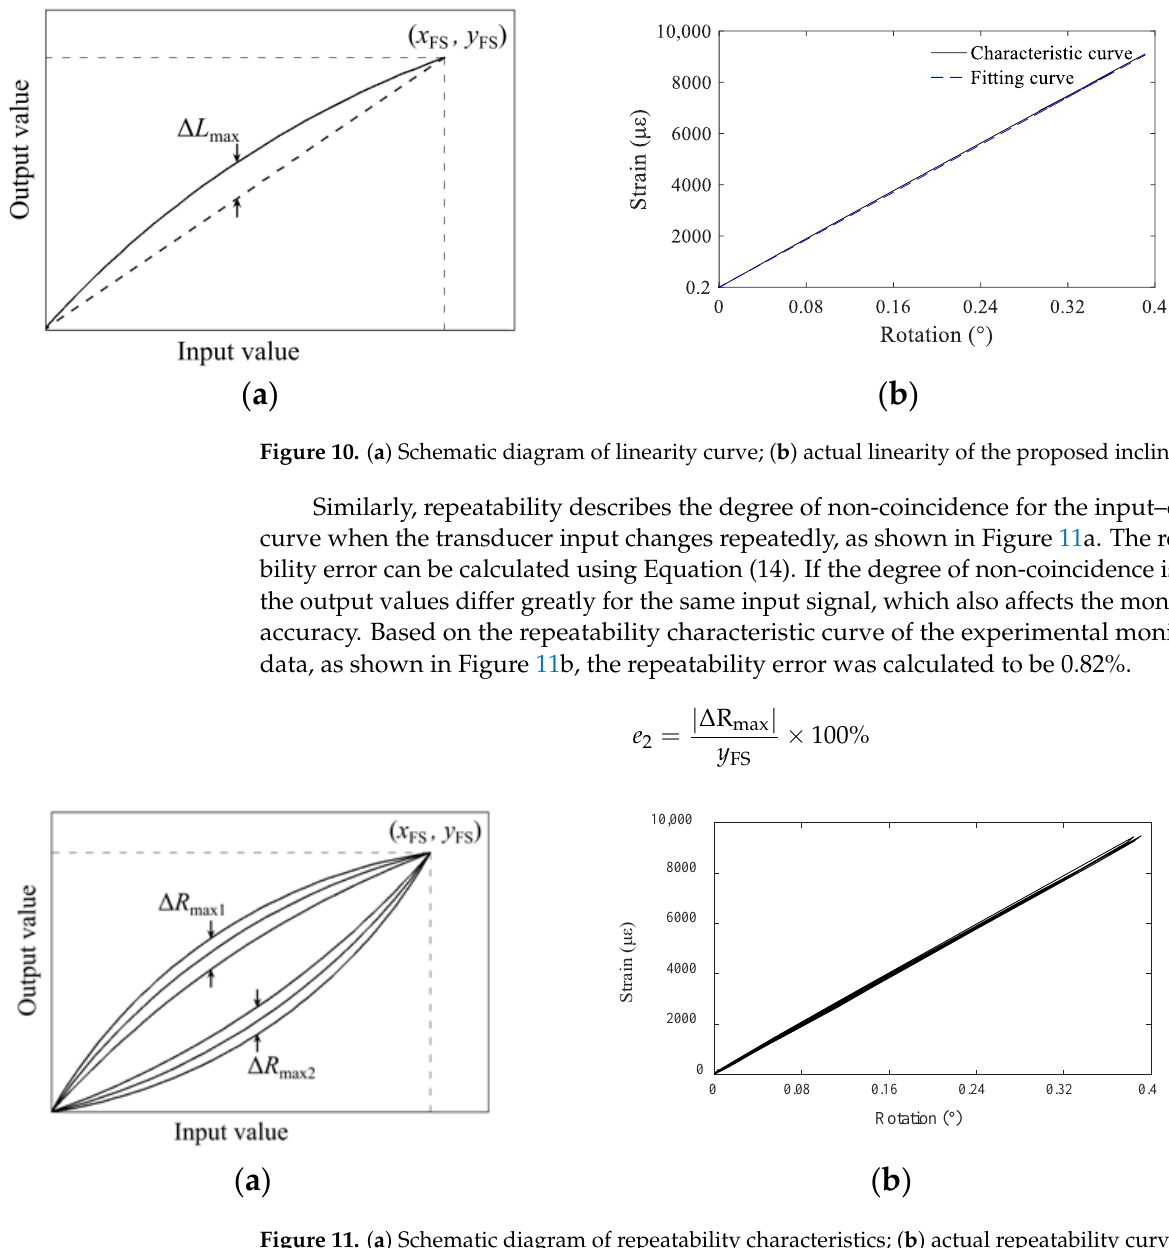
Figure 11. ( a ) Schematic diagram of repeatability characteristics; ( b ) actual repeatability curve of the proposed inclinometer.